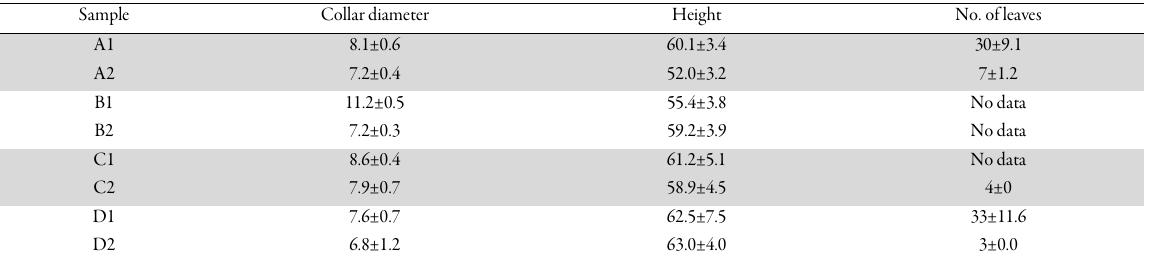
Table 2. Growth parameters of D. tripetala under the interaction effect of top soil and saw dust substrates